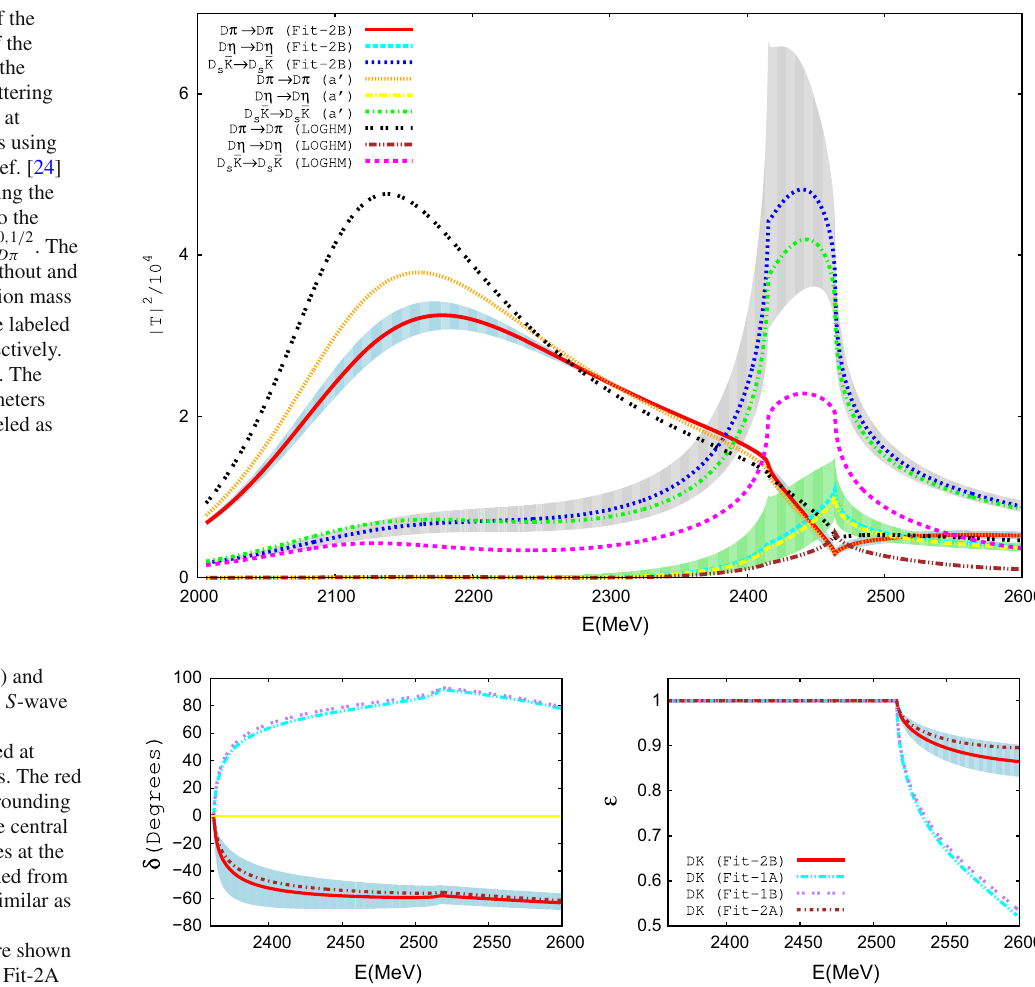
Fig. 9 Phase shifts ( δ ) and inelasticities ( ε ) of the S -wave DK scattering with ( S , I ) = ( 1 , 0 ) obtained at physical meson masses. The red solid lines and the surrounding areas correspond to the central values and uncertainties at the one-sigma level obtained from Fit-2B, respectively. Similar as Figs. 5 and 6, only the central-value results are shown for Fit-1A, Fit-1B and